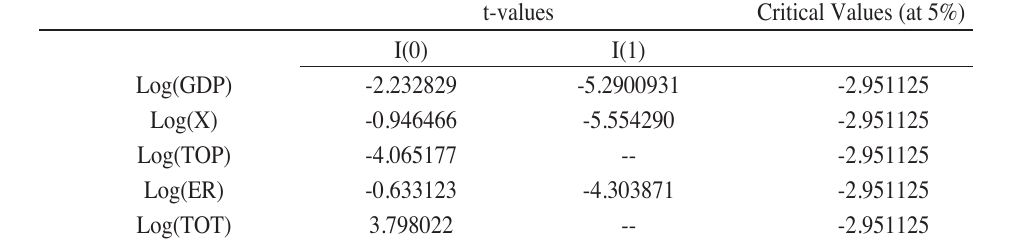
Table 1: Level of Stationarity of